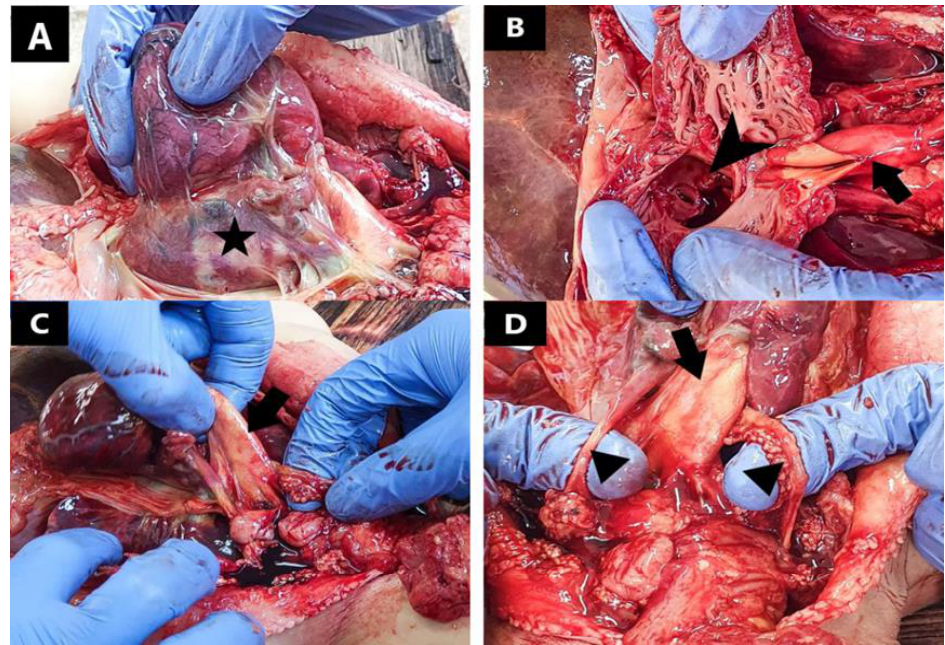
Figure 1. Macroscopic aspect of myocardium and great vessels: ( A ) (star) common atrium; ( B ) complete atrioventricular canal defect (arrowhead) and partially dissected common arterial trunk (arrow); ( C ) (arrow) common arterial trunk; ( D ) bilateral superior vena cava (triangle) and common arterial trunk (arrow).